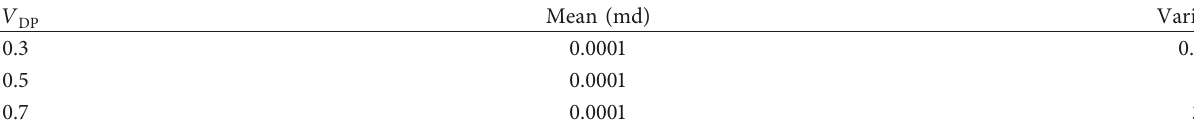
Table 4: Numerical attributes considered for caprock permeability.